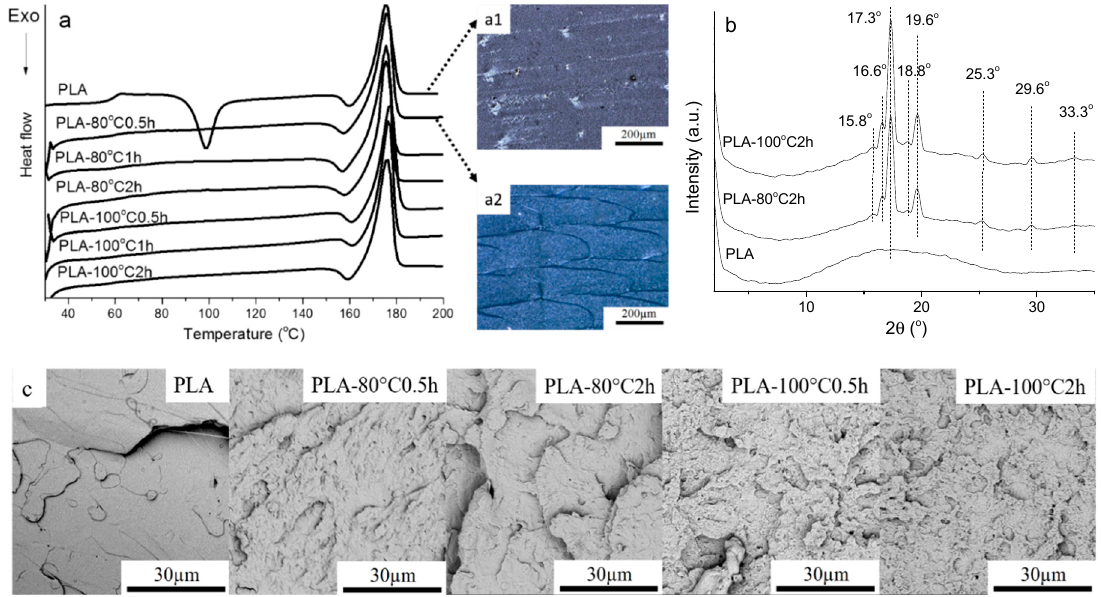
Figure 1. ( a ) Thermal curves, ( b ) Selected XRD curves, ( c ) Selected SEM images of cryo-fracture surface of PLA (poly(lactic acid)) samples before and after annealing (0.5 to 2 h, 80 or 100 °C); insert ( a1 ): POM of neat PLA, ( a2 ): POM of PLA—80 °C 0.5 h annealing; DSC characteristics are listed in Table S3 of the SI.